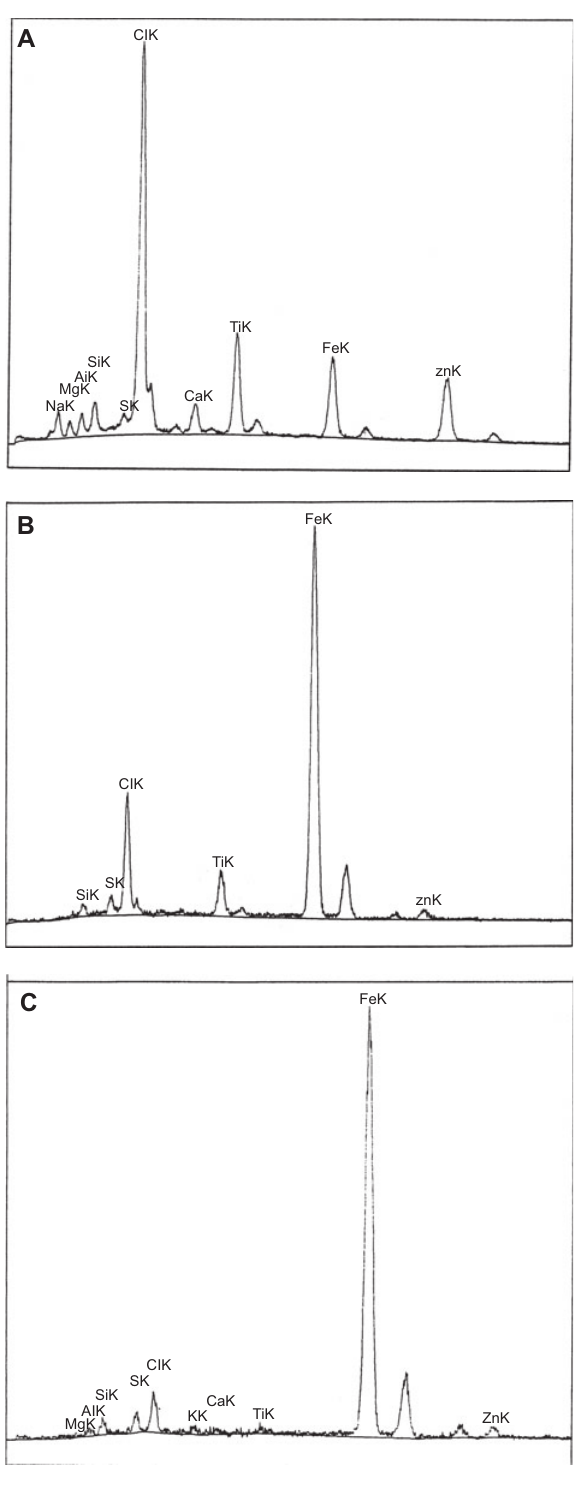
Figure 8 EDS spectra of organic coatings after experiment cycles (A) 0.5a, (B) 1a, and (C) 2a.